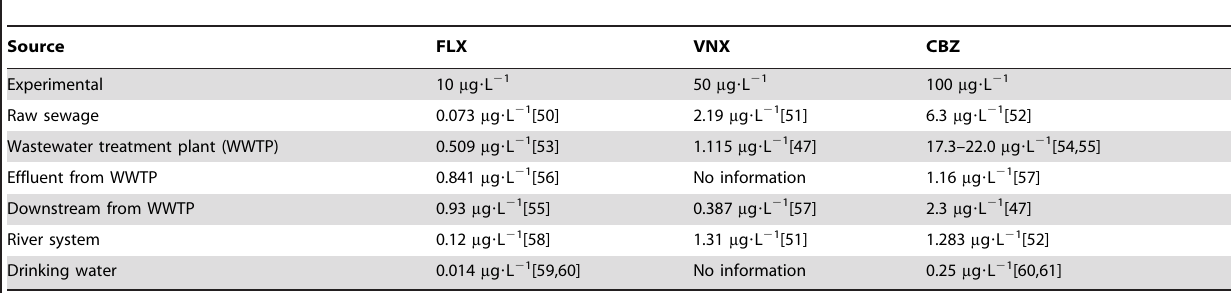
Table 1. Observed values of psychoactive pharmaceuticals in various systems.